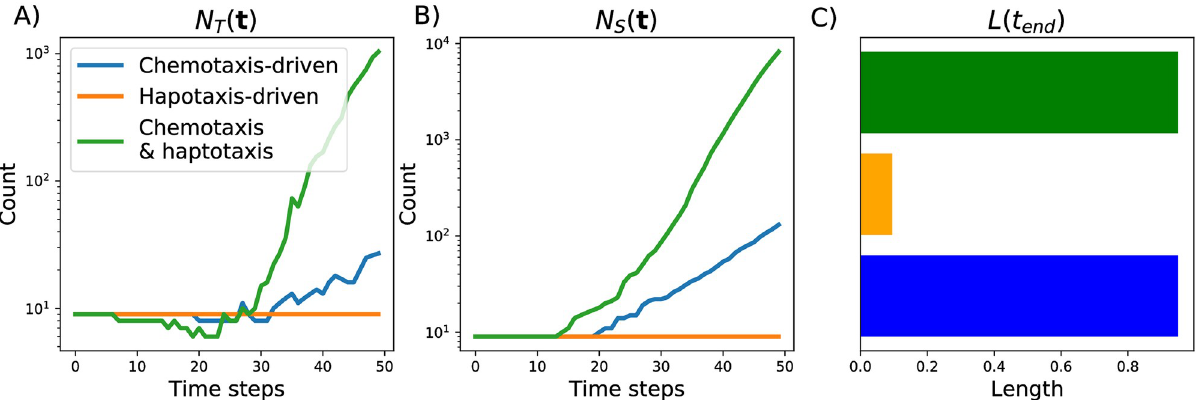
Fig 9. The standard descriptors used to summarize model simulations. We show how the following descriptors change over 50 time steps for the three simulations presented in Fig 7: A) the number of tip cells, N T ( t ), B) the number of vessel segments, N S ( t ), and C) the final vessel length, L ( t end ).